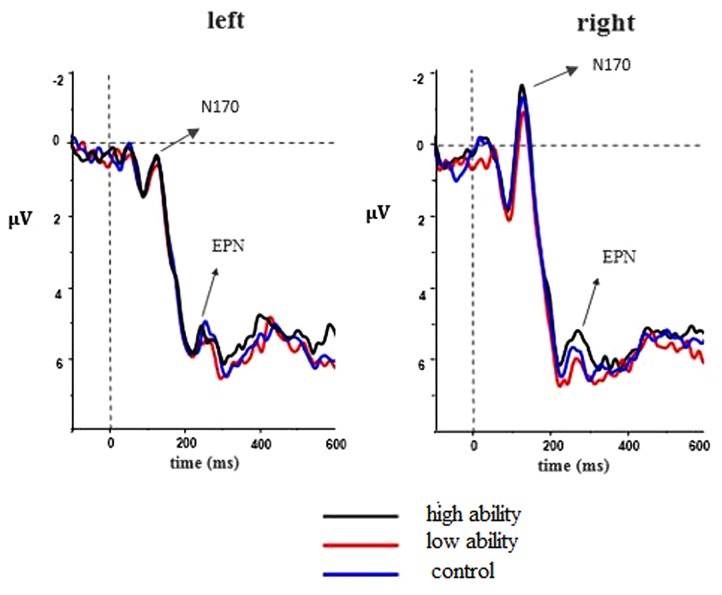
Grand-averaged event-related potential (ERP) waveforms for high, low, and control ability conditions. The ROI of left laterality includes CP5, P5, P7, PO7; and the corresponding right laterality includes CP6, P6, P8, PO8.